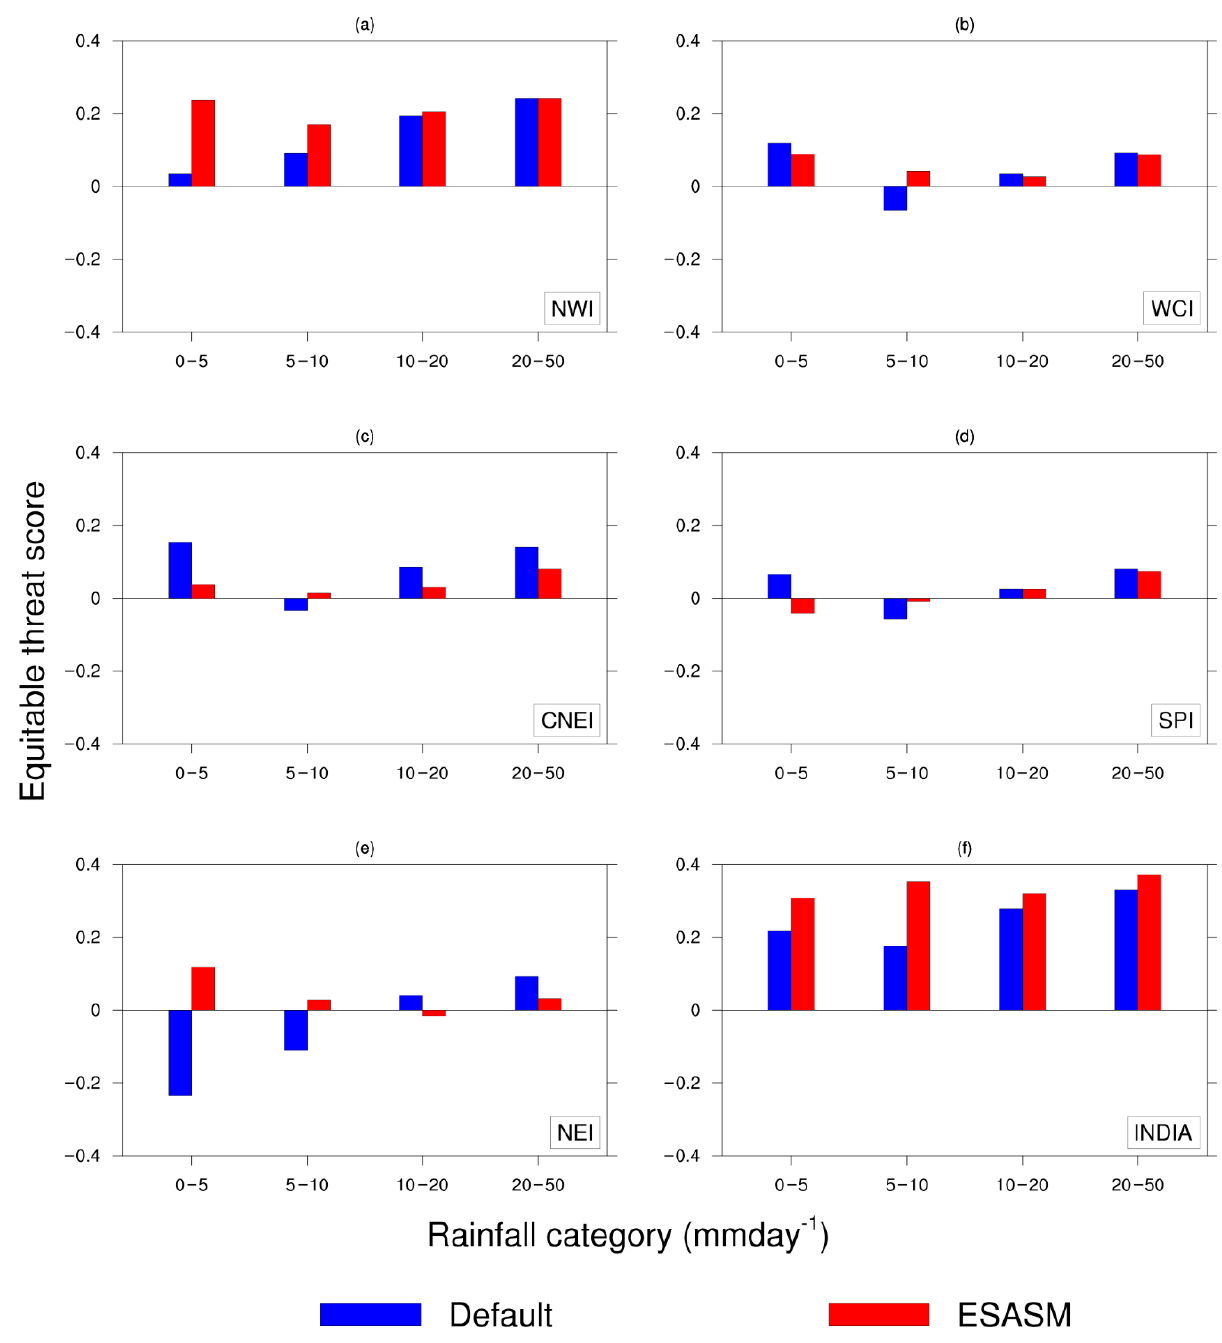
Figure 14. Same as Figure 13, but for the year